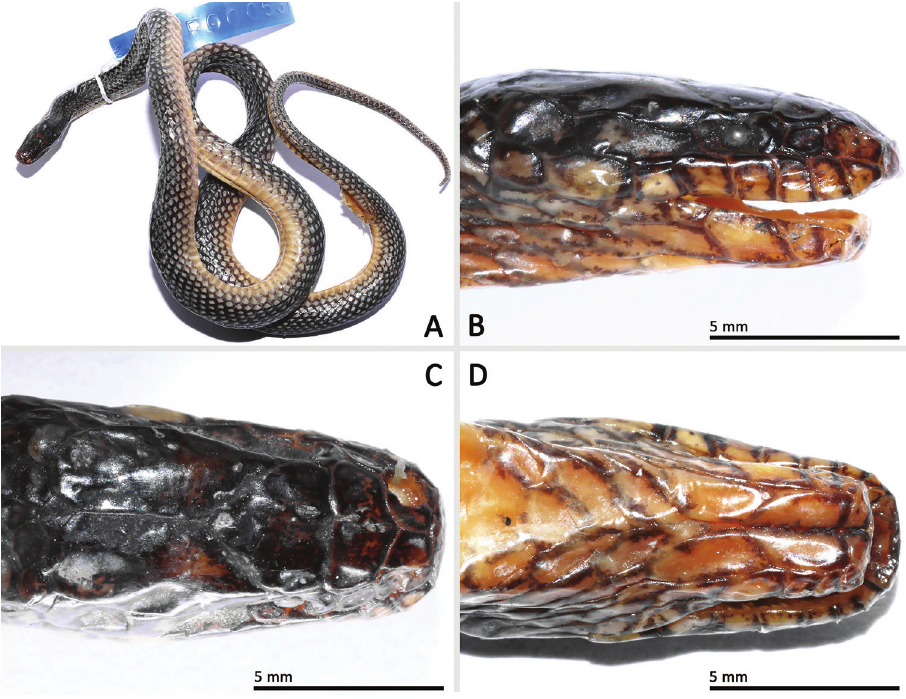
Figure 3. Morphological features of Opisthotropis haihaensis (SYS r000537) from Shiwandashan Nature Reserve, Guangxi, China. A Habitus view B–D close-up of head scales. Photos by Jian